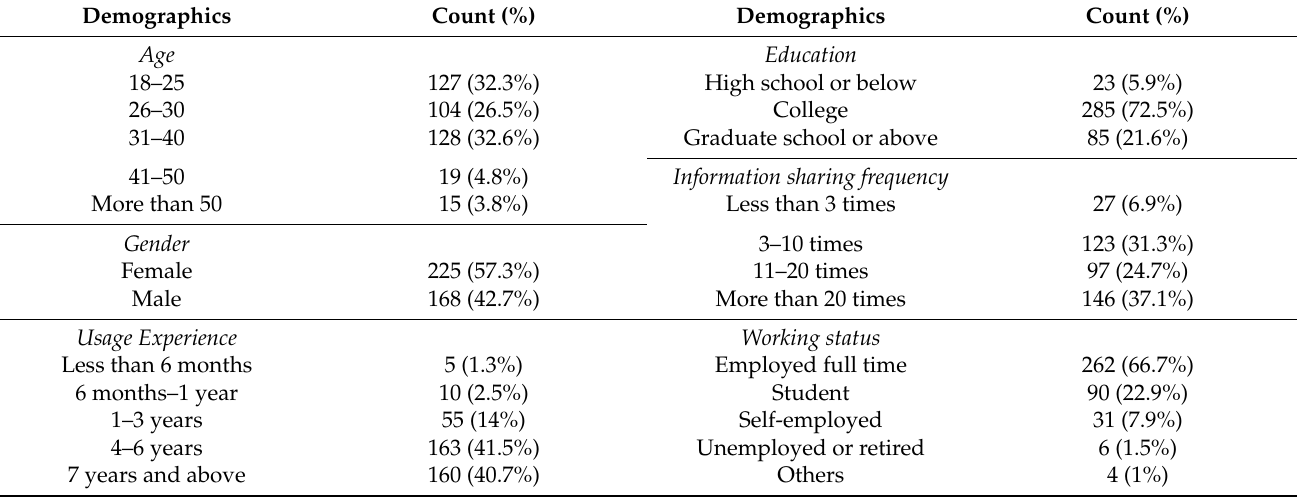
Table 1. The details of samples ( n =